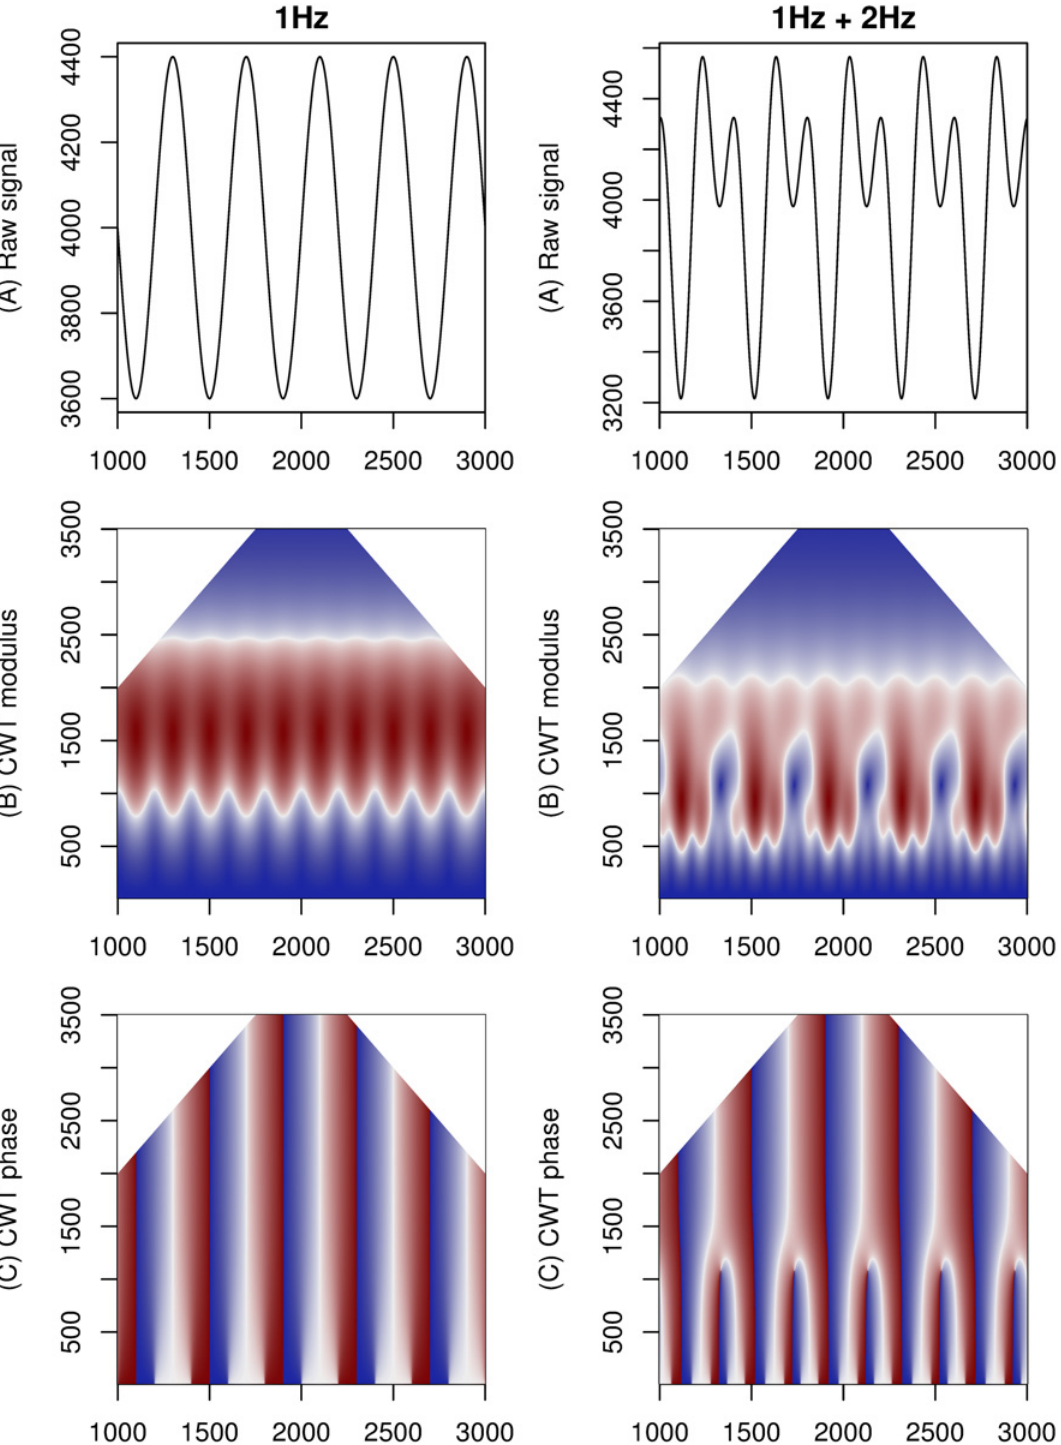
Fig 2. Examples of visualization of 1 Hz (on the left) and composite 1 Hz + 2 Hz harmonic signal (on the right). From top: (A) raw signal, (B) modulus of the wavelet transform, (C) phase of the wavelet transform.